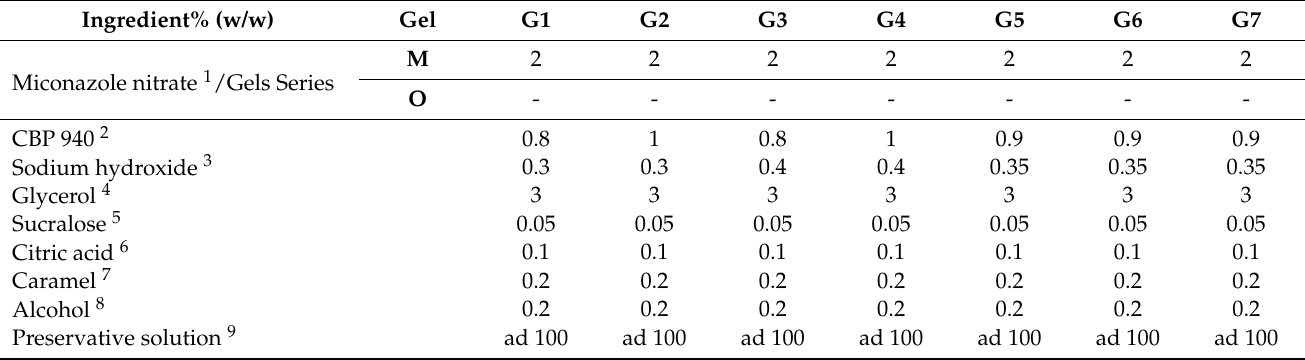
Table 1. Composition of the two studied series of